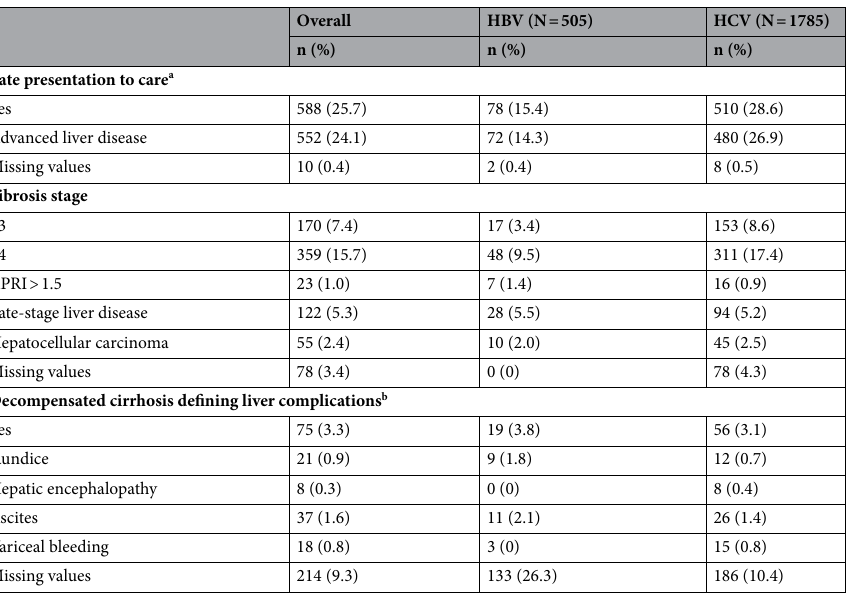
Table 2. Description of HBV and HCV LP patients (N = 2290), categorised by ALD/LSLD in 11 Spanish hospitals. ALD advanced liver disease, APRI aspartate aminotransferase to platelet ratio, F3 stage 3 fibrosis,